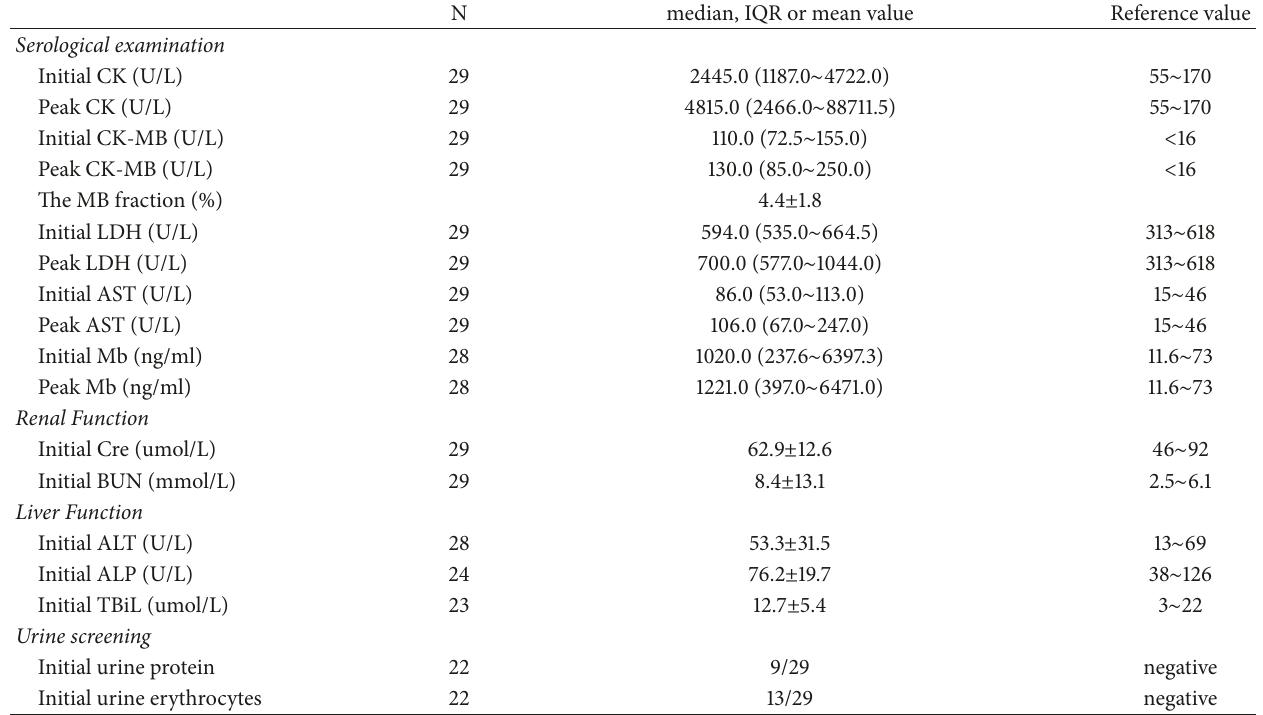
Table 3: Laboratory test results of twenty-nine cases during